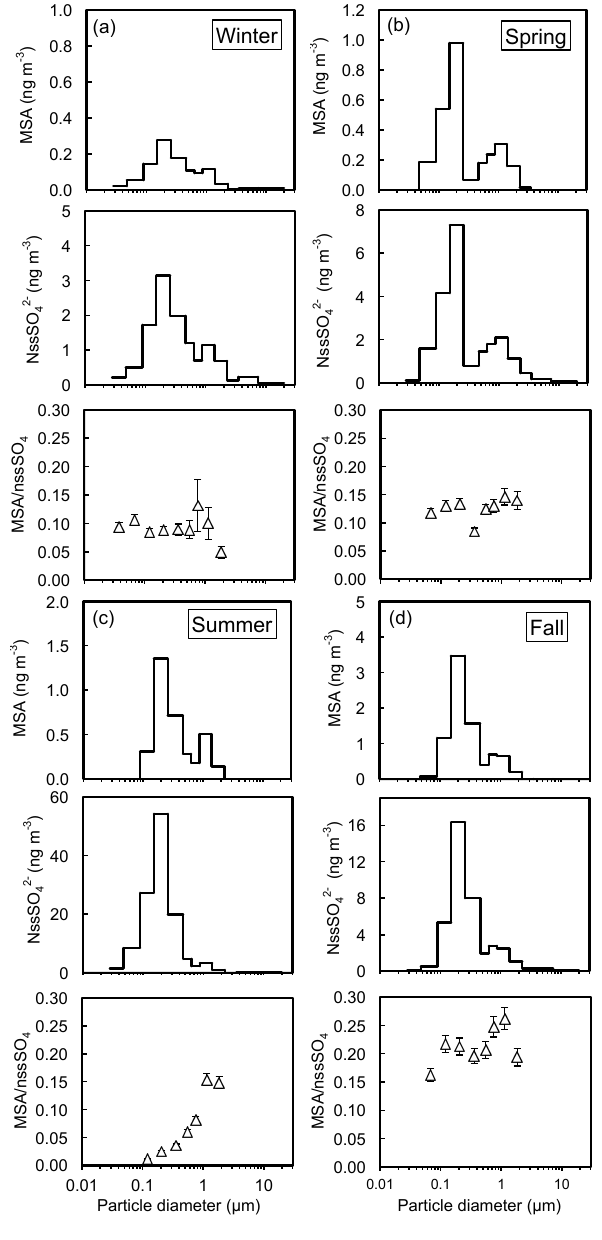
Figure 5. Size-segregated composition of sulfur aerosol (MSA, non-sea-salt sulfate, and MSA / nssSO 4 ) at Concordia in winter ( a 14–28 August 2009), spring ( b 9–22 October 2010), summer ( c 9– 22 January 2010), and fall ( d 28 March–11 April